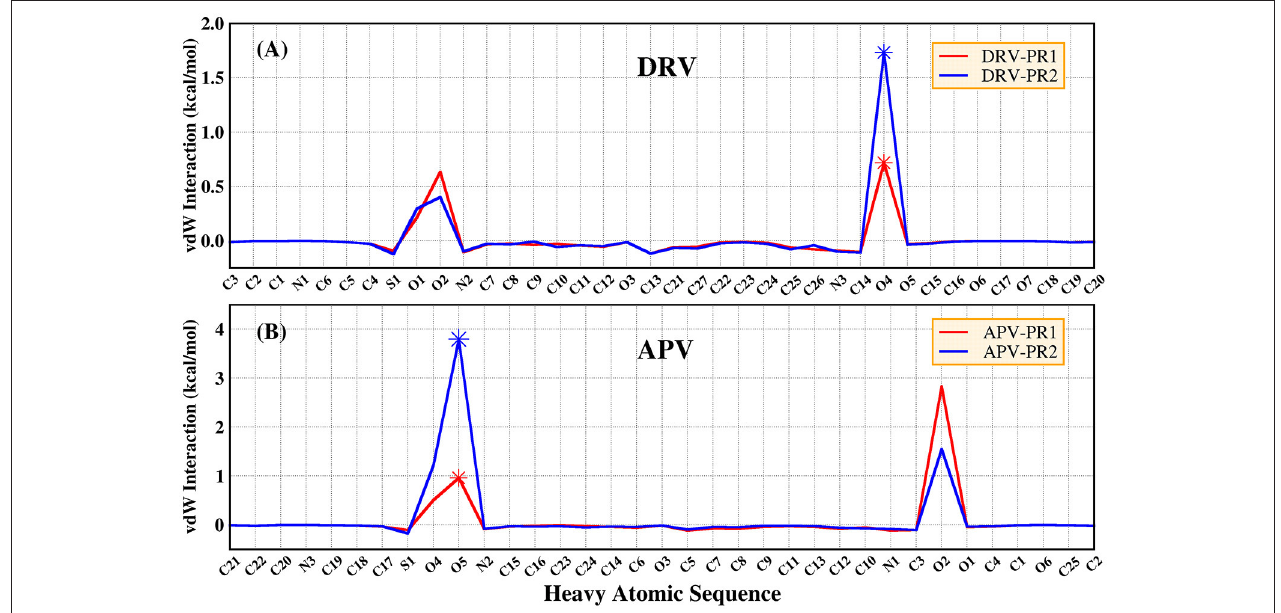
FIGURE 8 | The vdW interaction of bridging water and per heavy atom of inhibitors. (A) DRV complexes. (B) APV complexes.